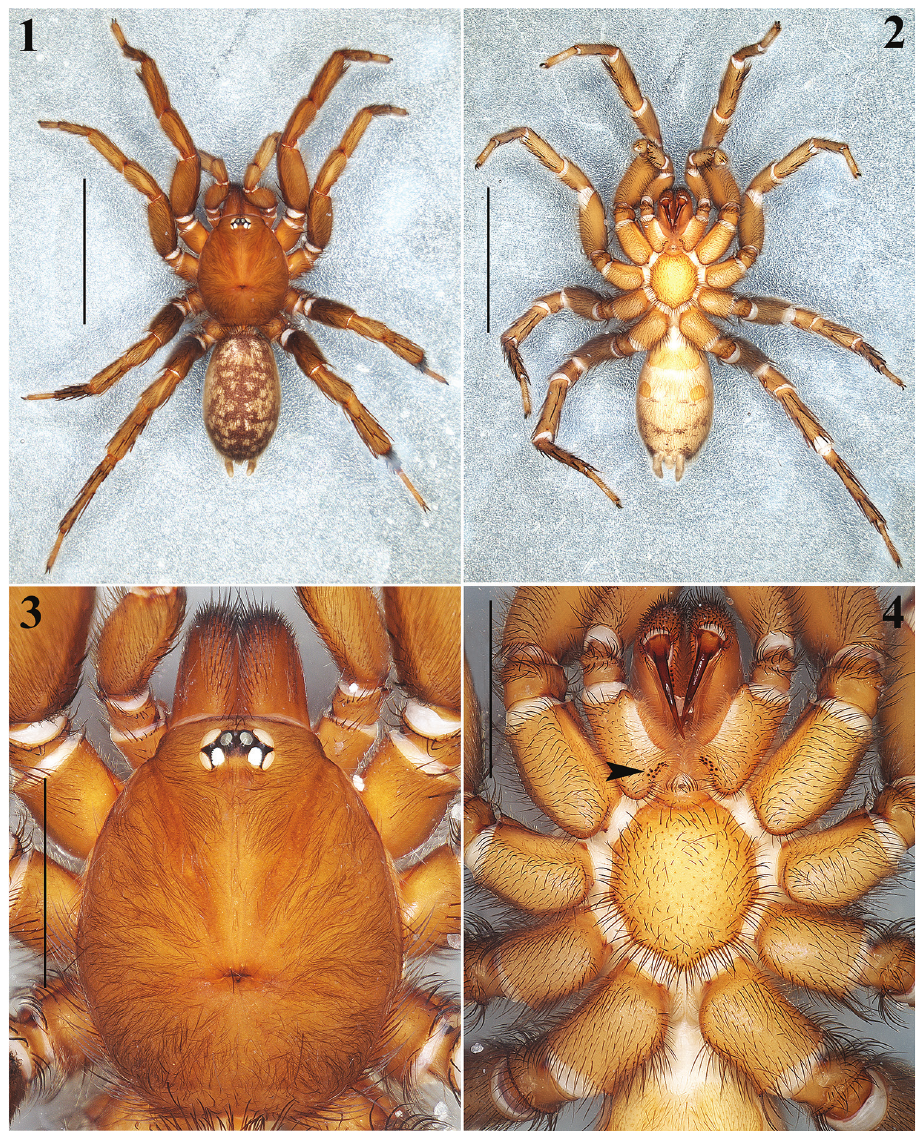
Figures 1–4. Aptostichus sabinae sp. n. Male holotype: 1–2 Habitus, dorsal and ventral views respectively 3 Carapace, dorsal view 4 Prosoma, ventral view showing coxae, sternum, labium and endites (arrow indicates cuspules). Scale bars 0.5 mm ( 1 , 2 ), 0.2 mm ( 3 , 4 ).